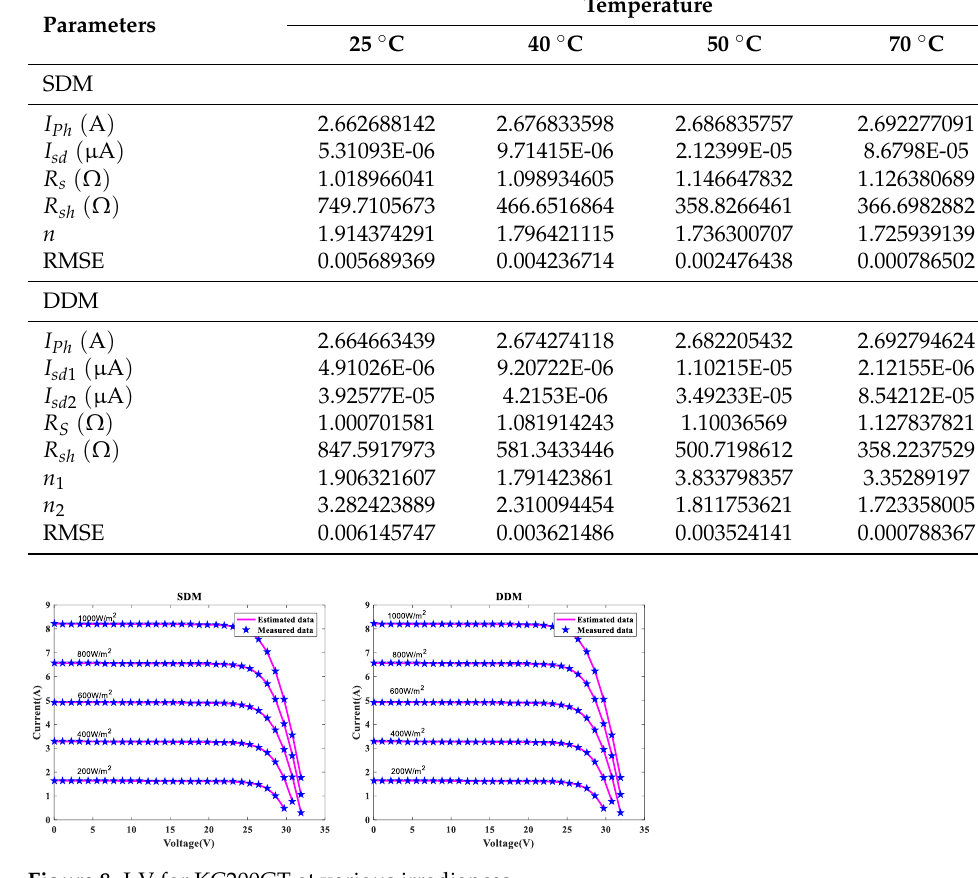
Figure 8. I-V for KC200GT at various irradiances.